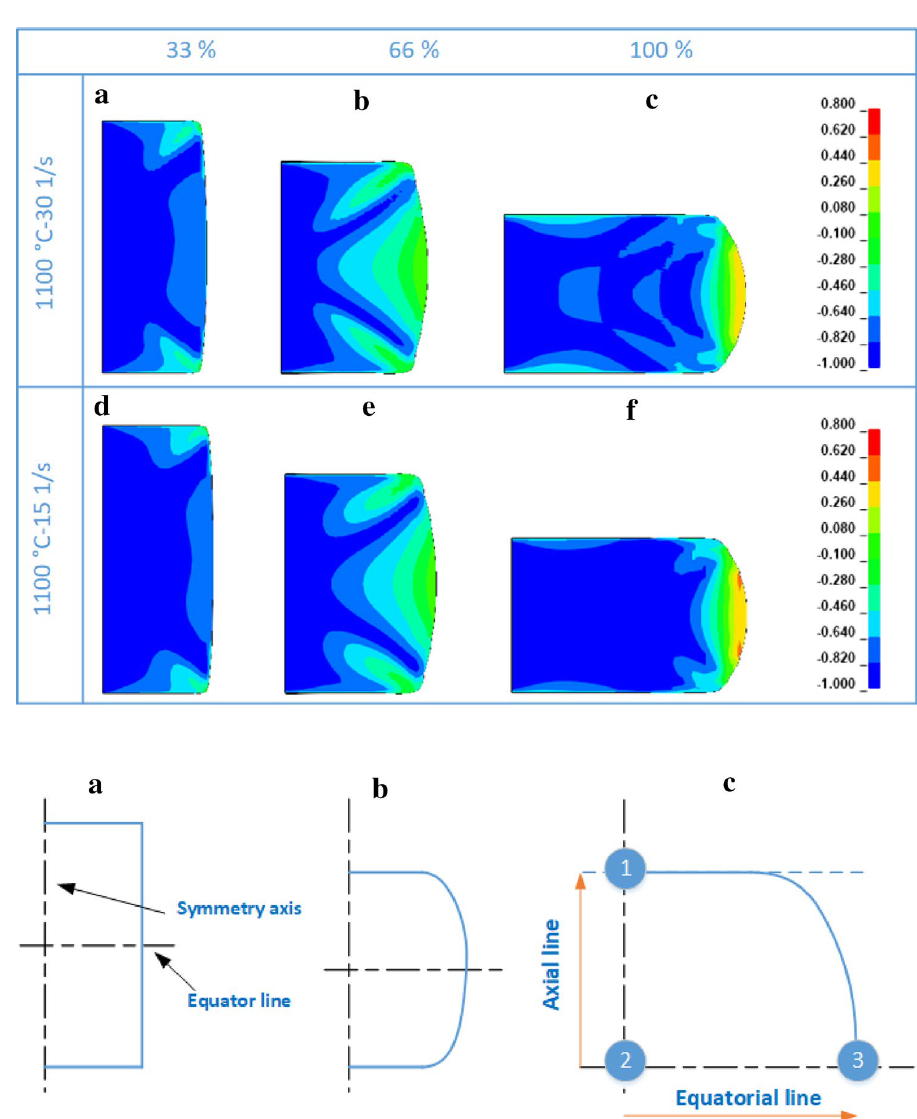
Fig. 9 Lode parameter at three different stages during com- pression for 1100 °C